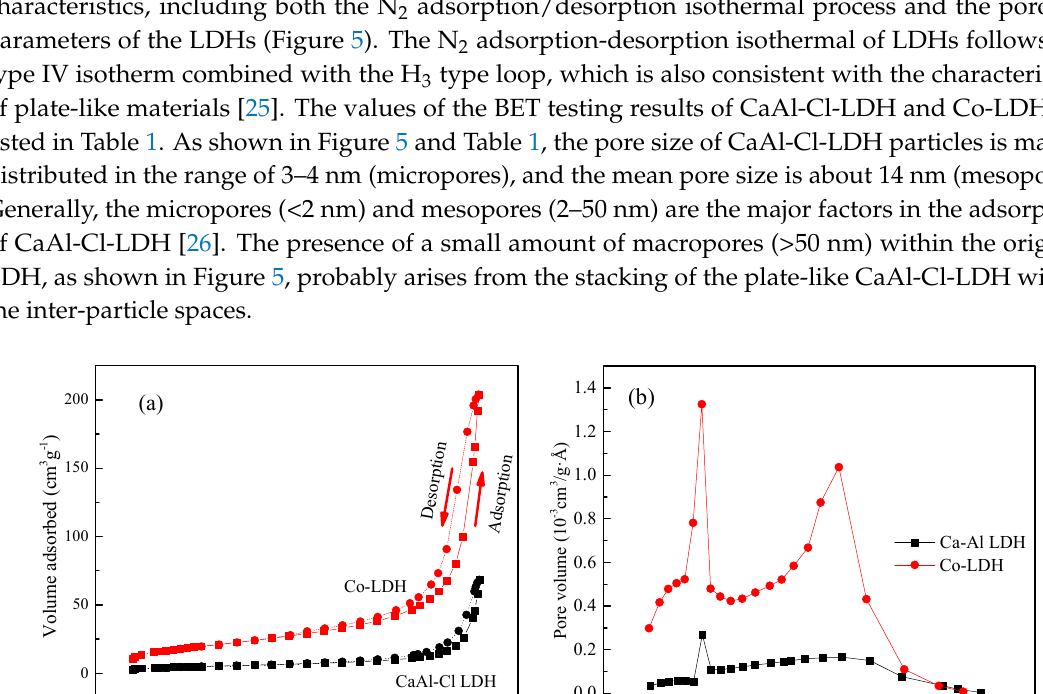
Figure 4. TEM image of CaAl‐Cl‐LDH ( a ) and HR‐TEM images of Ca‐Al‐Cl‐LDH ( b ) and Co‐LDH ( c ).